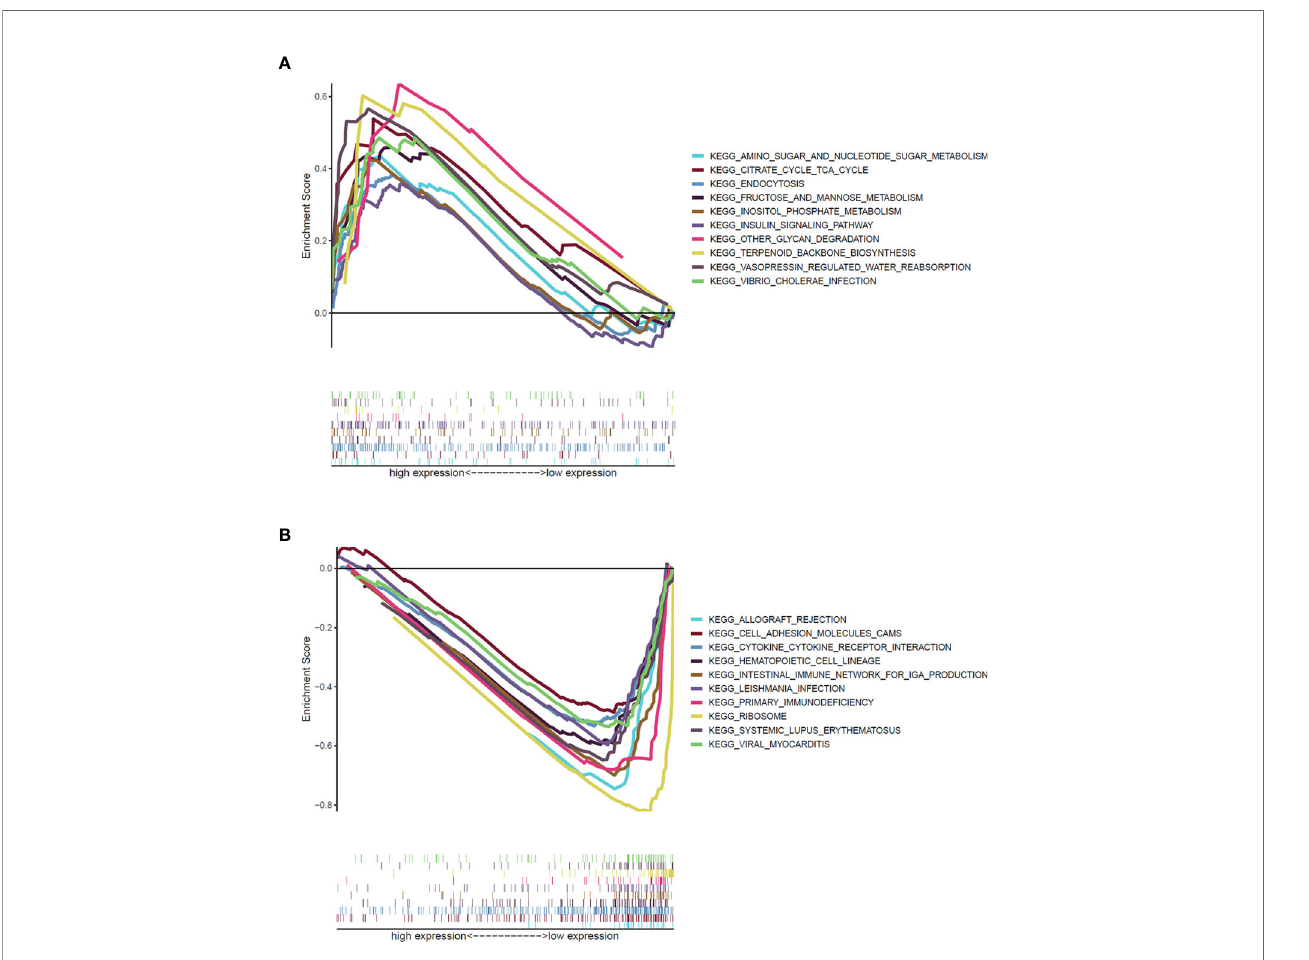
FIGURE 6 | GSEA revealed biological pathways correlated with ATP2C2 in the cohort from TCGA. (A) Gene sets enriched in ATP2C2 high-expression group. (B) Gene sets enriched in ATP2C2 low-expression group. NOM p < 0.05, FDR q < 0.25, and |NES| > 1 are set as the signi fi cance